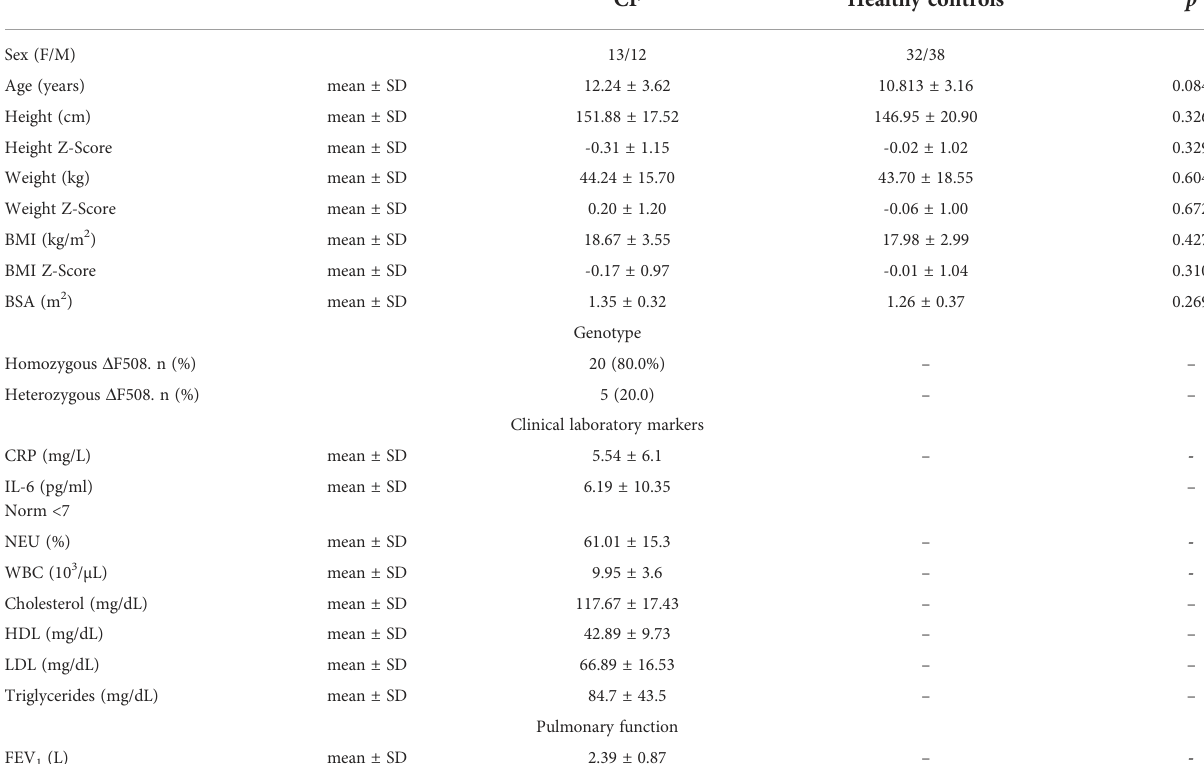
TABLE 1 Baseline demographic and clinical data of the study